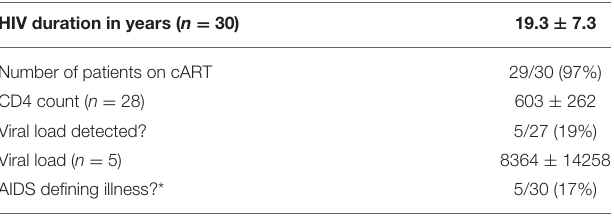
TABLE 3 | Diabetes care benchmarks and prevalence of targets being met of diabetes clinic attendees with HIV-infection and diabetes vs. diabetes controls. HIV-infection Diabetes and diabetes